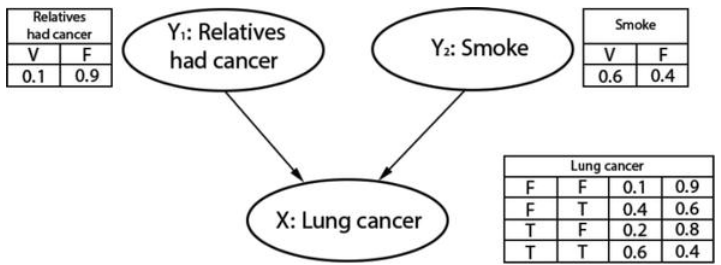
Figure 3. A simple BN model indicating the inter-dependencies between a lung cancer classifier and the affecting risk factors (adopted from